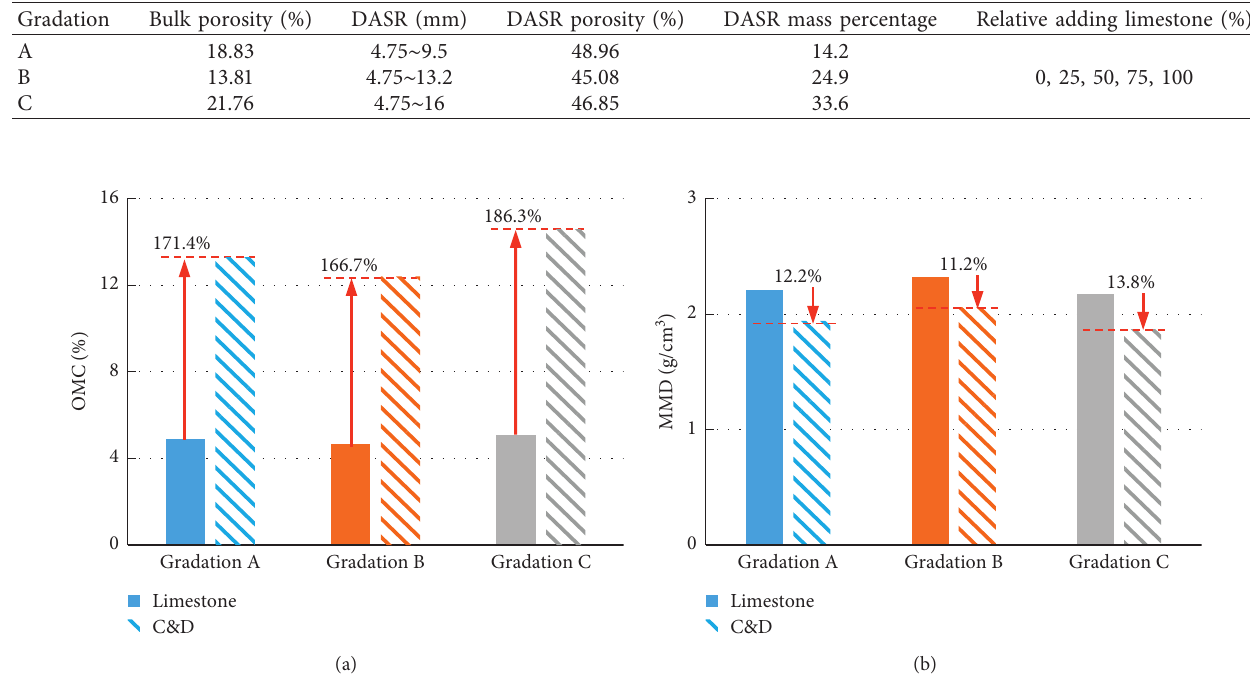
Figure 2: Results of compaction tests: (a) optimum moisture content (OMC) and (b) maximum dry density